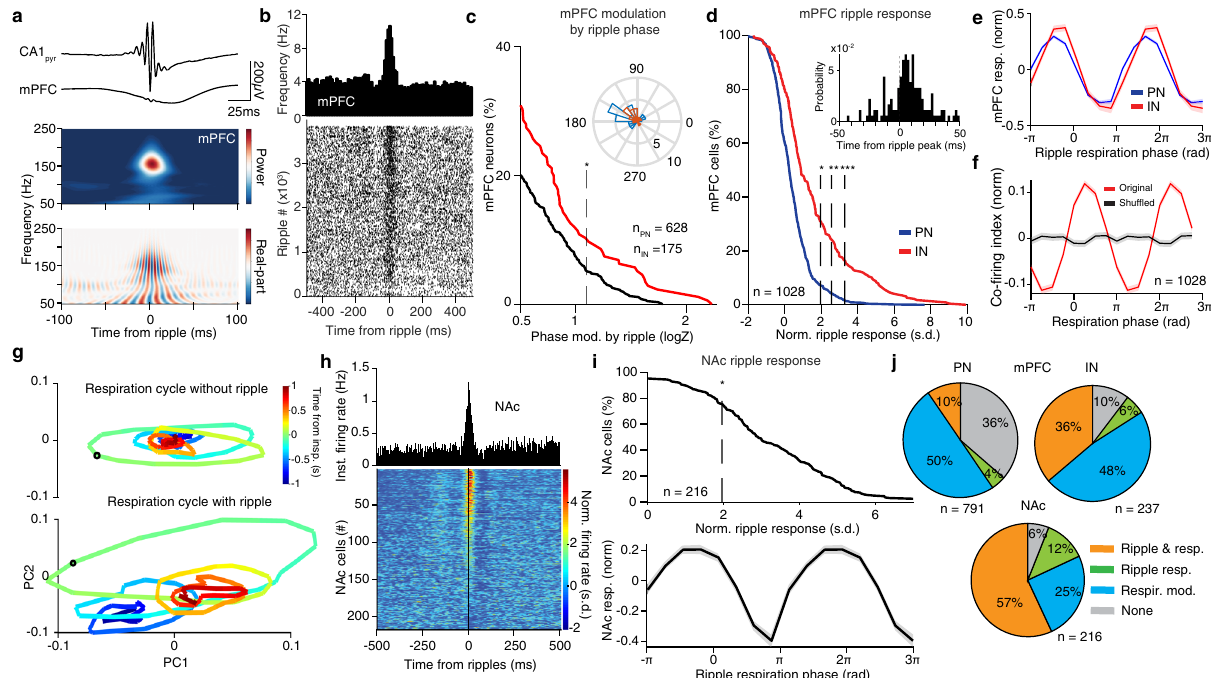
Fig. 8 Breathing modulates the cortico – hippocampal interaction. a Example is ripple-triggered CA1 pyr and mPFC LFP traces and wavelet spectral decomposition of mPFC LFP power (upper) and real part (lower) ( n = 3162 ripples). b Example mPFC unit spiking across ripples (bottom) and cross- correlogram of unit fi ring to ripple occurrence (top). c Cumulative distribution of the modulation strength by ripple oscillation phase for all mPFC PNs ( n = 628 cells) and INs ( n = 175 cells). Inset, preferred phase distribution for all signi fi cantly phase-modulated cells. d Cumulative distribution of the ripple- triggered fi ring of mPFC PNs ( n = 791 cells) and INs ( n = 237 cells) in response to ripples ( N = 11 mice). Inset, distribution of relative time of peak fi ring. e Prefrontal ripple-evoked response for PN (blue traces) and IN (red traces), as a function of the breathing phase of occurrence of ripple. f Co- fi ring index for all pairs of dCA1 and mPFC cells ( n = 14,412, N = 13 mice) compared to shuf fl e control. g Example trajectory of the mPFC population dynamics around inspiration without (top) and with (bottom) a ripple oscillation occurring during that period in the oscillation. Black circle denotes time 0, pseudocolor codes for the time from inspiration onset. h Cross-correlation of fi ring with respect to ripple time for one example NAc unit (top) and color-coded cross- correlograms for all NAc cells ( n = 216 cells). i Top, cumulative distribution of the ripple-triggered normalized fi ring of NAc cells ( n = 216 cells) in response to ripples ( N = 4 mice). Bottom, ripple-evoked response as a function of the breathing phase of occurrence of ripple. j Top, pie charts indicating the percentage of all mPFC PNs (left; n = 791 cells) and INs (right; n = 237 cells) that are either phase modulated by respiration (resp. mod), responding signi fi cantly to ripples (ripple resp.), being both signi fi cantly modulated by breathing and signi fi cantly responsive to ripples or neither. Bottom, similarly, for all NAc cells ( n = 216 cells). s.d. standard deviations, arb. units arbitrary units. Shaded areas, mean ± SEM. Stars indicate signi fi cant phase modulation levels (* P < 0.05; ** P < 0.01; *** P <